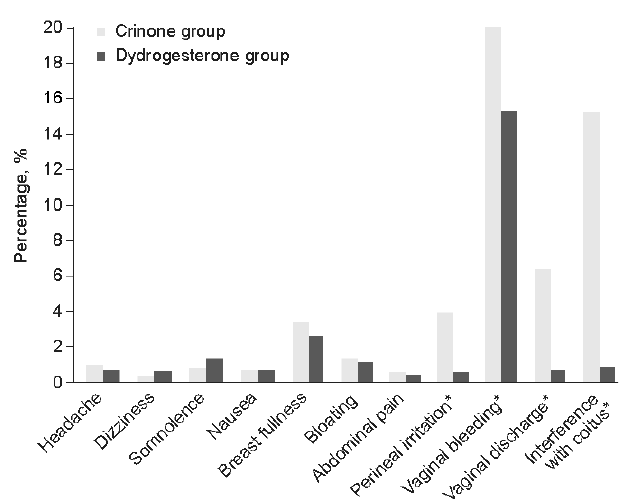
Figure 2. Tolerability of dydrogesterone versus vaginal progesterone gel (8%) in luteal phase sup- port [68]. * p < 0.05 by Chi-square test, in favor of Crinone group. Reprinted from Eur J Obstet Gynecol Reprod Bio, Vol 186, Tomic V, Tomic J, Klaic DZ, et al. Oral dydrogesterone versus vaginal progesterone gel in the luteal phase support: randomized controlled trial, Pages 49–53, Copyright 2015, with permission from Elsevier.